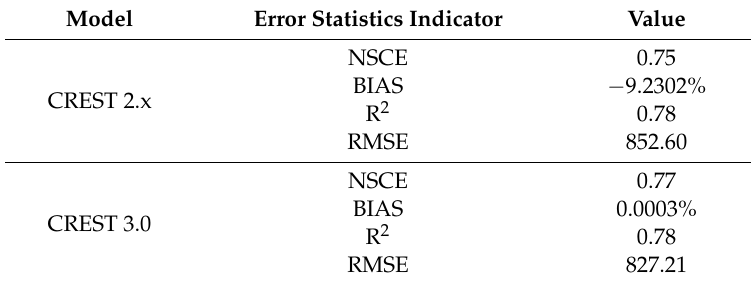
Table 2. Error statistics of CREST 2.x and 3.0. NSCE: Nash–Sutcliffe coefficient of efficiency; RMSE: root mean square error.